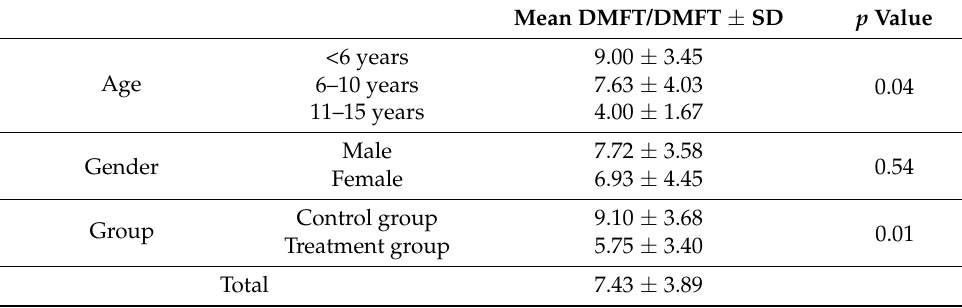
Table 4. The mean caries index scores of the study participants.